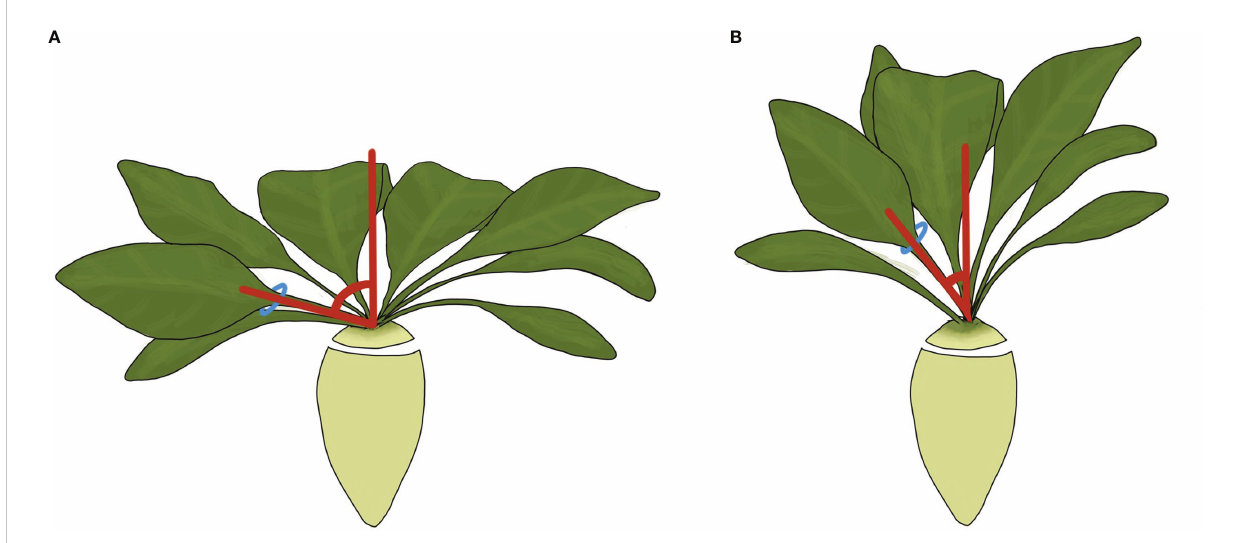
FIGURE 1 An illustration of a prostrate (A) and upright (B) sugar beet canopy. The petiole angle is shown in red and is greater in prostate varieties. Originally published in Tillier et al. (2023); reproduced under CC BY